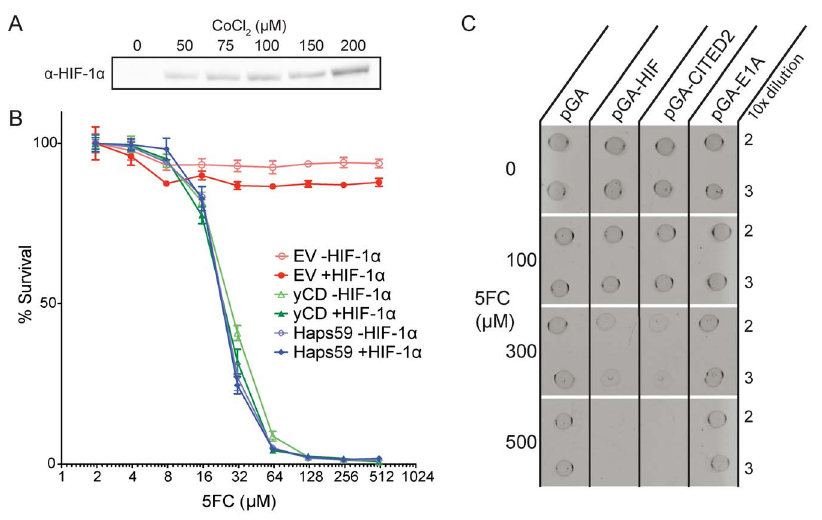
Figure 5. Characterization of the effects of Haps59 expression in Flp-In 293 cells and E. coli . (A) Western blot with anti-HIF-1 a antibodies showing that the addition of CoCl 2 causes the accumulation of HIF- 1 a in Flp-In 293 cells. See Figure S5 for full blot. (B) Toxicity of 5FC to stable isogenic pools of Flp-In 293 cells containing EV, yCD, and Haps59. Cells were grown in the absence (i.e. 2 HIF-1 a ) or presence (i.e. + HIF-1 a ) of 50 m M CoCl 2 , and increasing concentrations of 5FC. Percent survival was calculated by measuring the total DNA of surviving cells in each well and normalizing between wells containing no 5FC (i.e. 100% survival) and wells containing no cells (i.e. 0% survival). Error bars represent the standard deviation across three replicates. (C) Dot toxicity assay indicates that CITED2 but not E1A activates Hap59 in E. coli . Equal density dilutions of log phase cultures of strains expressing Haps59 and either the p300 binding fragments of HIF-1 a , CITED2, or E1A were plated on increasing concentrations of